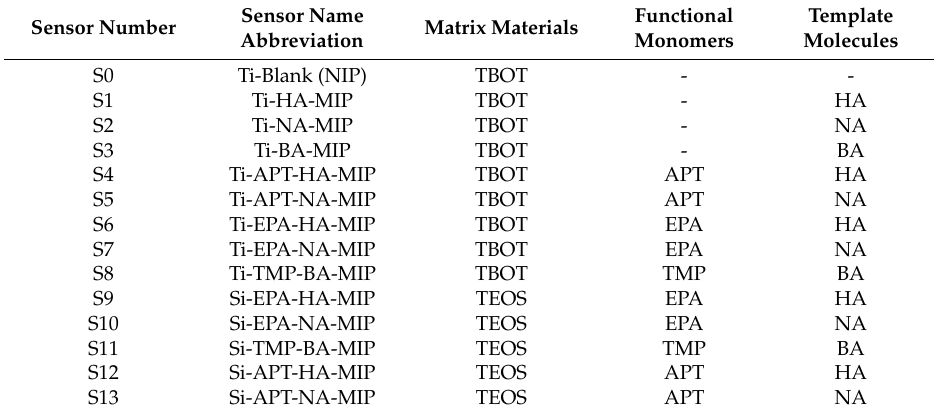
Table 1. Detailed information of 14 sensor channels fabricated by molecularly imprinted sol gels